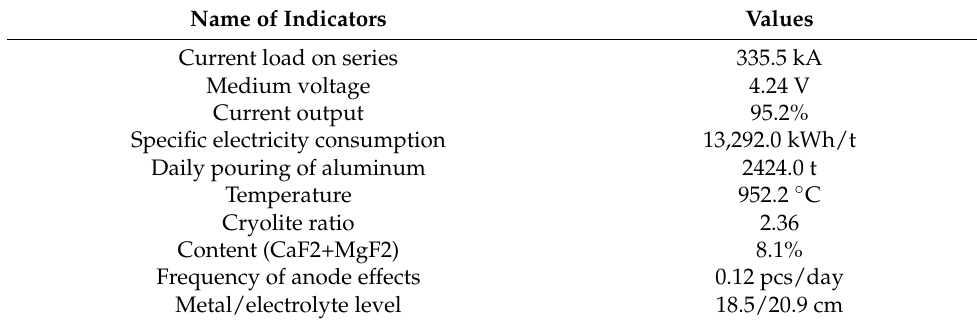
Table 2. The main characteristics of the electrolytic cell OA-300M [21 – 33].